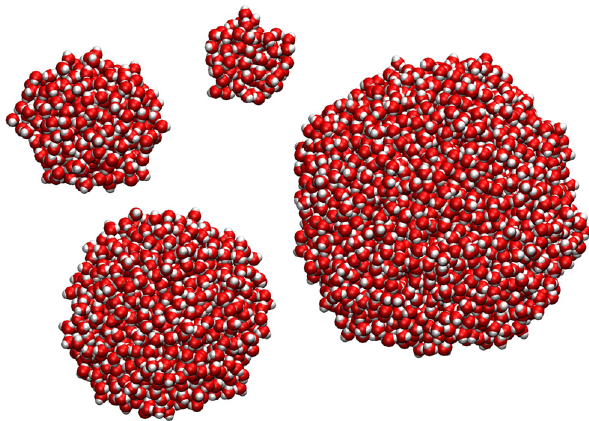
Fig. 1 Snapshots of simulated liquid water nanodroplets.